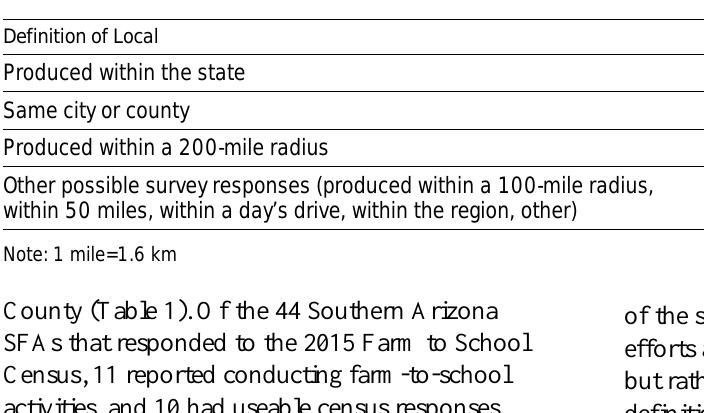
Table 2. Southern Arizona School Food Authorities’ (SFAs’) Geographic Definition of